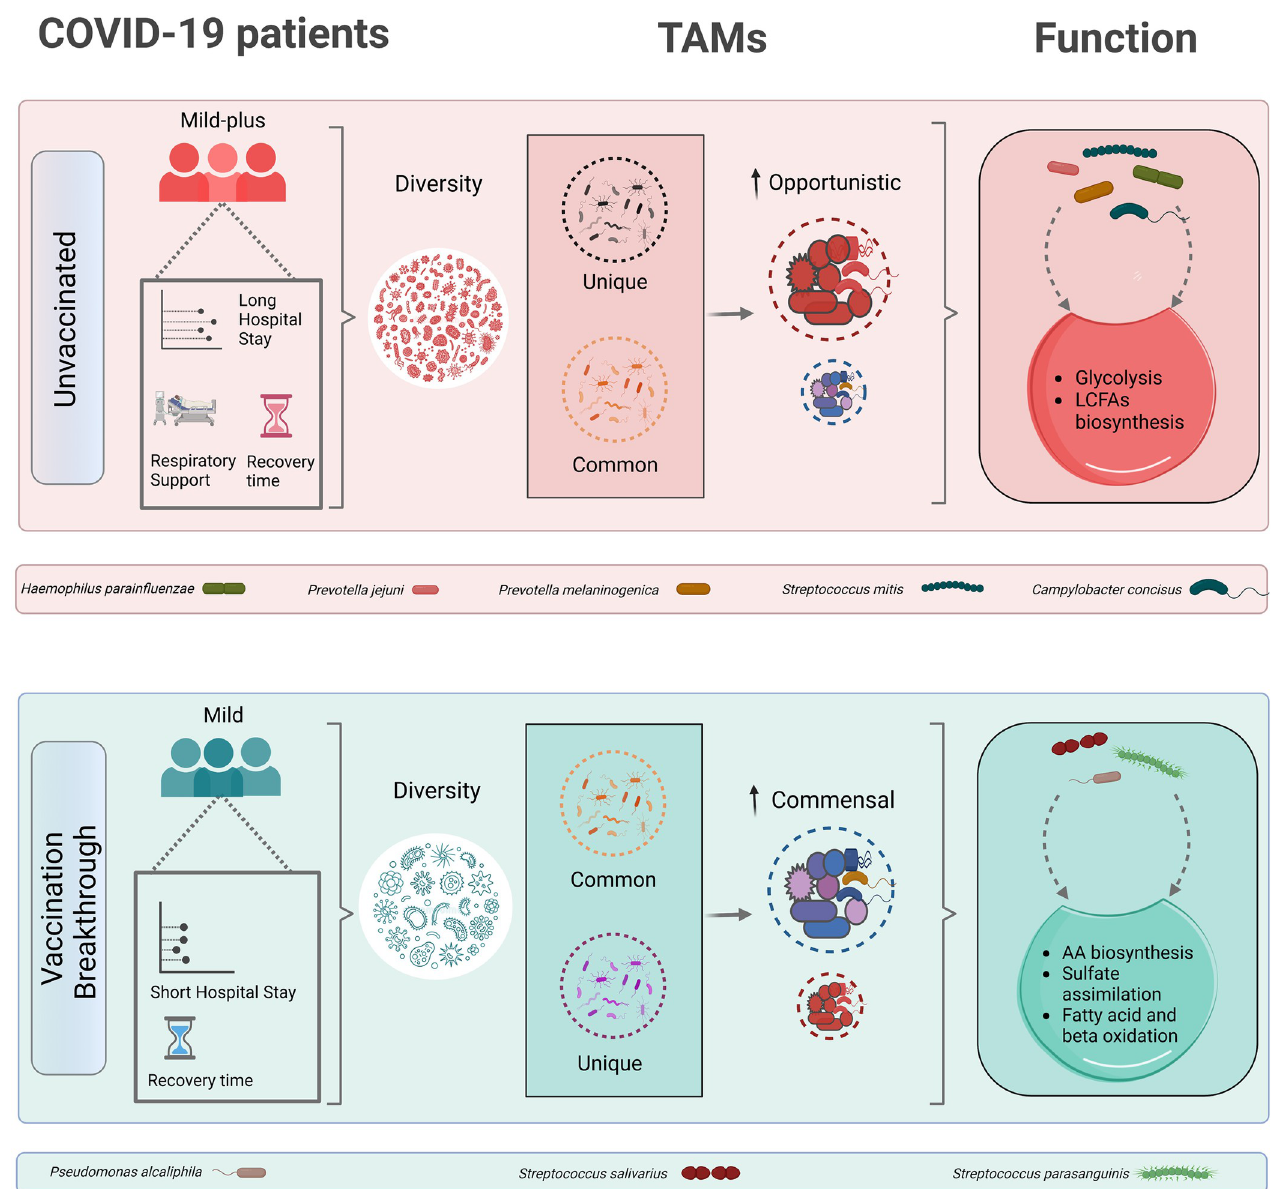
Fig 8. Summarizes differential abundance of commensals and opportunistic microbes modulating disease trajectory in vaccination breakthroughs and unvaccinated infections of SARS-CoV-2. Figure created with